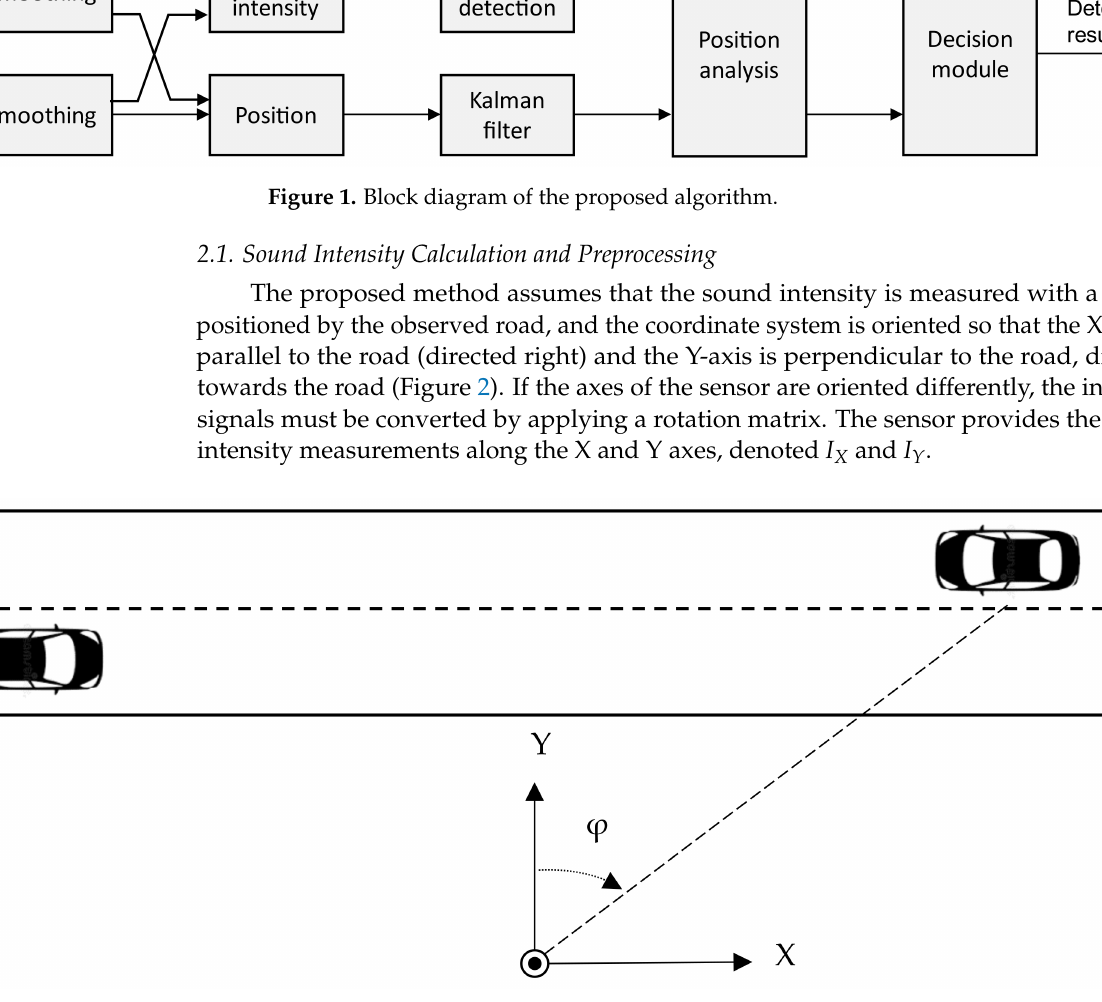
Figure 2. Orientation of the coordinate system relative to the road. A circle denotes the sensor